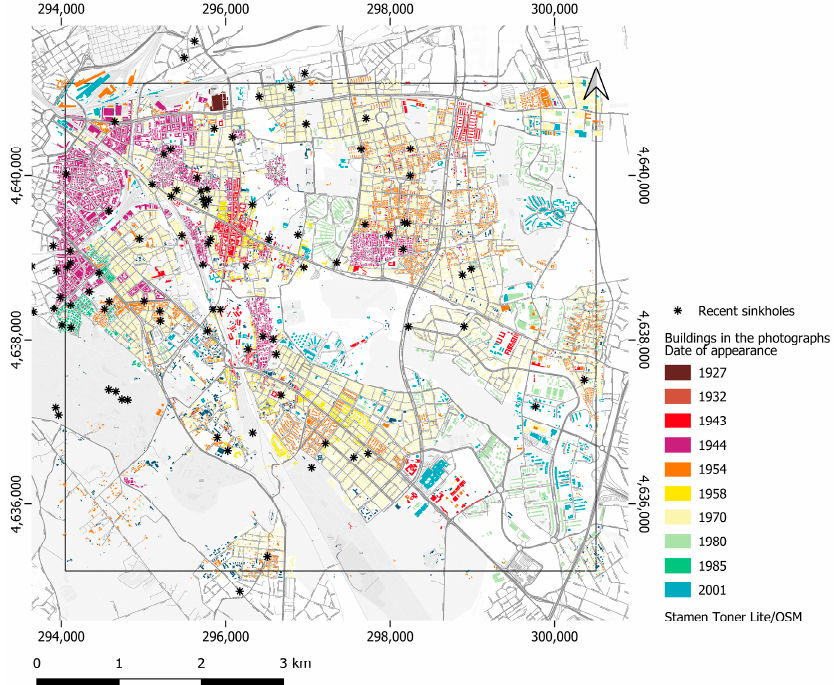
Figure 6. The thematic map displays the development of urbanization in the AOI gathered from historical photographs and the selection of recent sinkhole events collected from the news recorded in a point-vector catalog. The base polygon vector of Buildings comes from the CTR of Rome [73] released under a cc-by license, whose attribute table has been used to record the dates of appearance of each building in the HAPs.